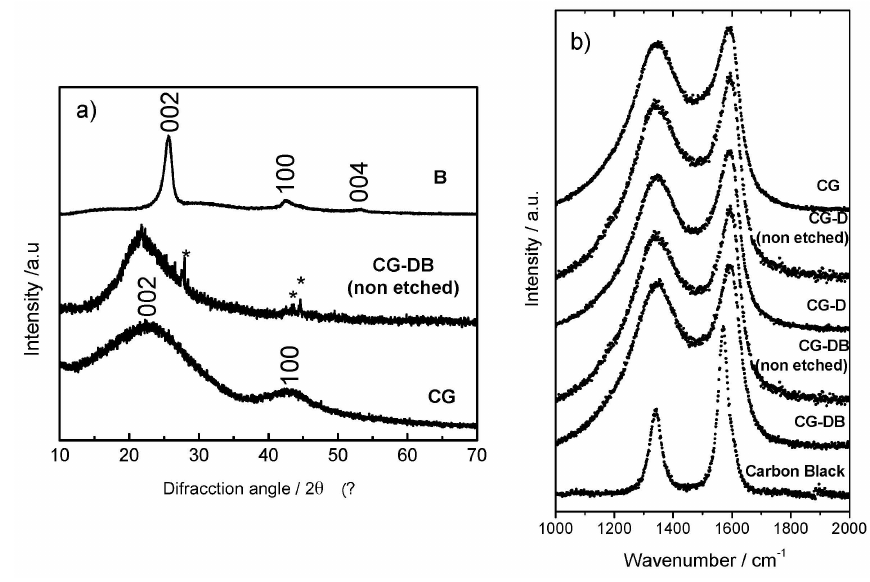
Figure 3. ( a ) X-ray diffraction patterns and ( b ) Raman spectra of the carbon aerogels showing the presence of the